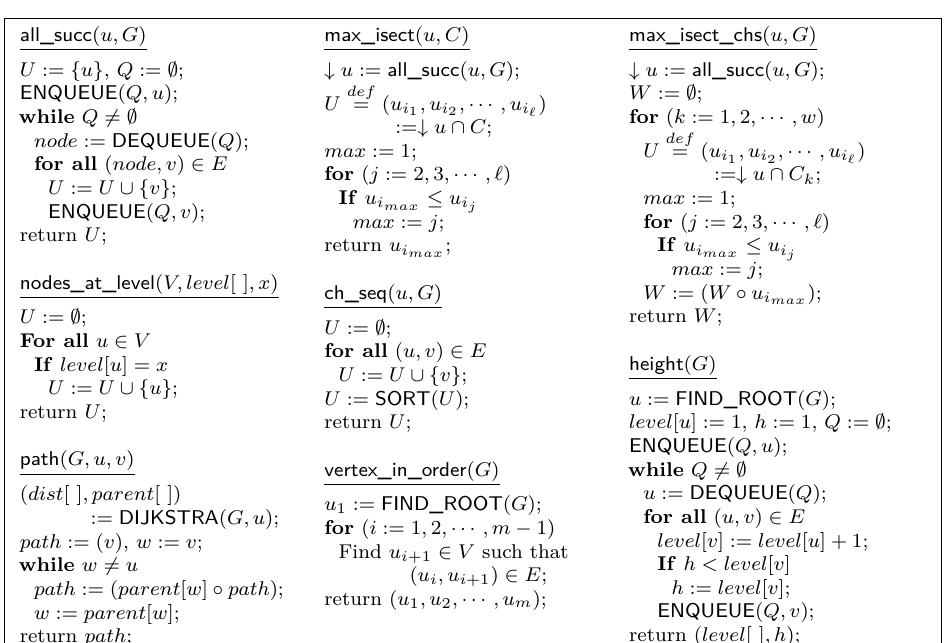
Key Assignment Scheme with Authenticated Encryption